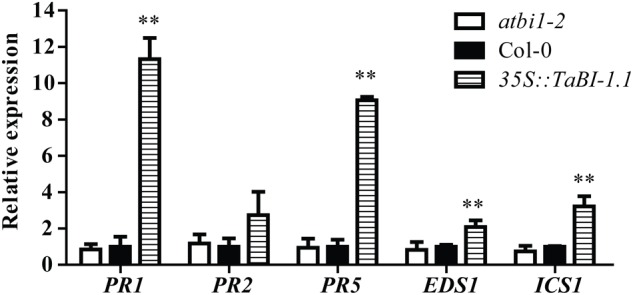
The expression levels of five SA-related genes in 2-week-old seedlings of atbi1-2, Col-0, and 35S::TaBI-1.1 transgenic Arabidopsis grown under normal condition were monitored by qRT-PCR. Arabidopsis actin2 was used as a reference. The expression levels of genes in Col-0 were set to “1.” Error bars indicate the SDs. The data represent the means ± SDs of three independent replicates. Asterisks indicate significant differences (∗P < 0.05 and ∗∗P < 0.01) compared with Col-0 (Student’s t-test).